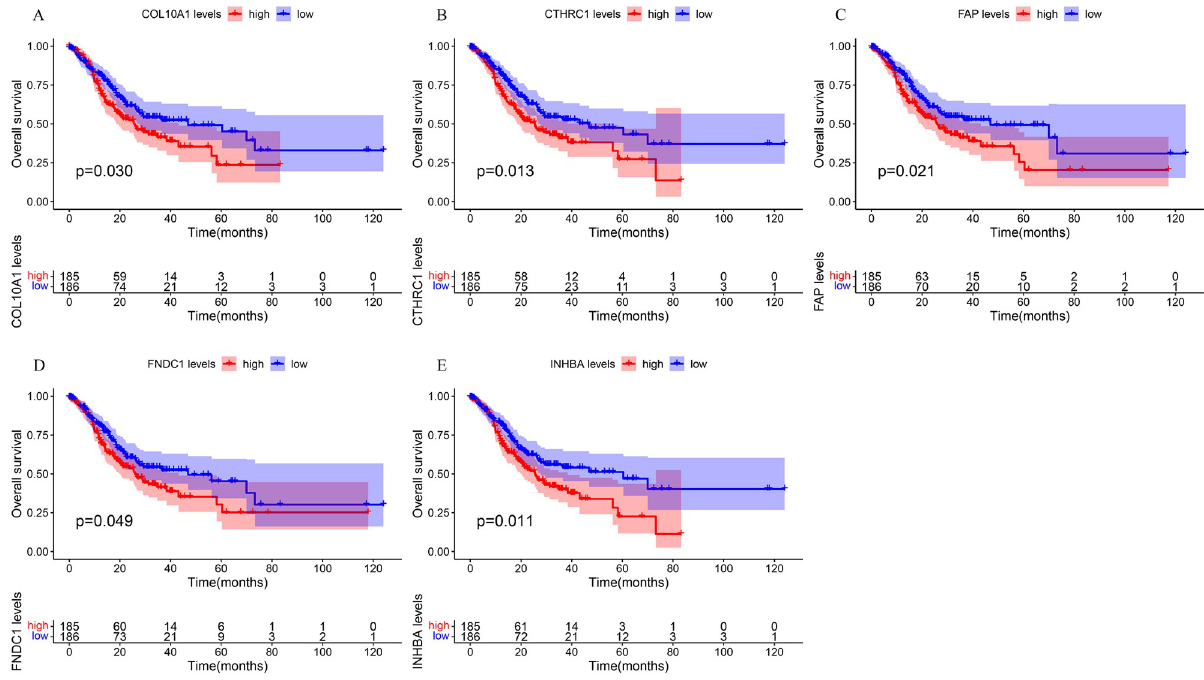
Fig 4. The Kaplan–Meier survival curves of the five genes in TCGA dataset. (A) COL10A1 (B) CTHRC1 (C) FAP (D) FNDC1 (E) INHBA .